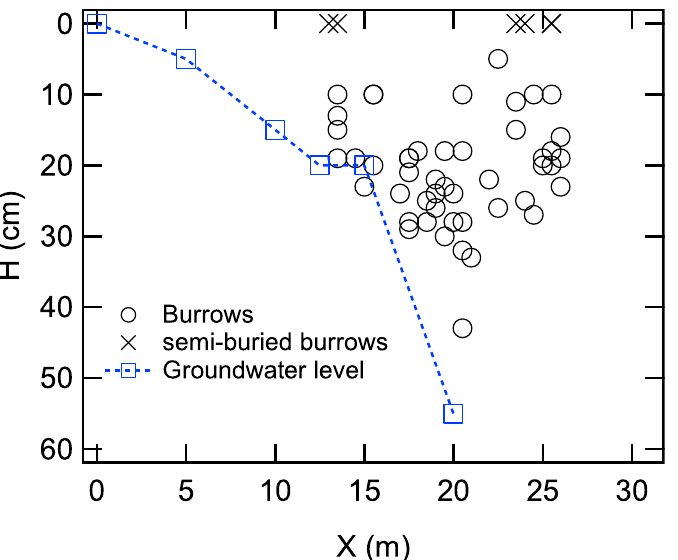
Fig 8. Depth of burrows relative to groundwater elevation and distance from shoreline (Tsu site). Burrows tend to become deeper as distance from shoreline increases. About 15 m landward from shore, the depth of burrows coincides with the groundwater elevation. However, burrows are shallower than the groundwater level at location more than 15 m from the shoreline. Semi-buried burrows (depicted as exes) indicate relatively old (seemingly inactive) burrows that are almost buried.